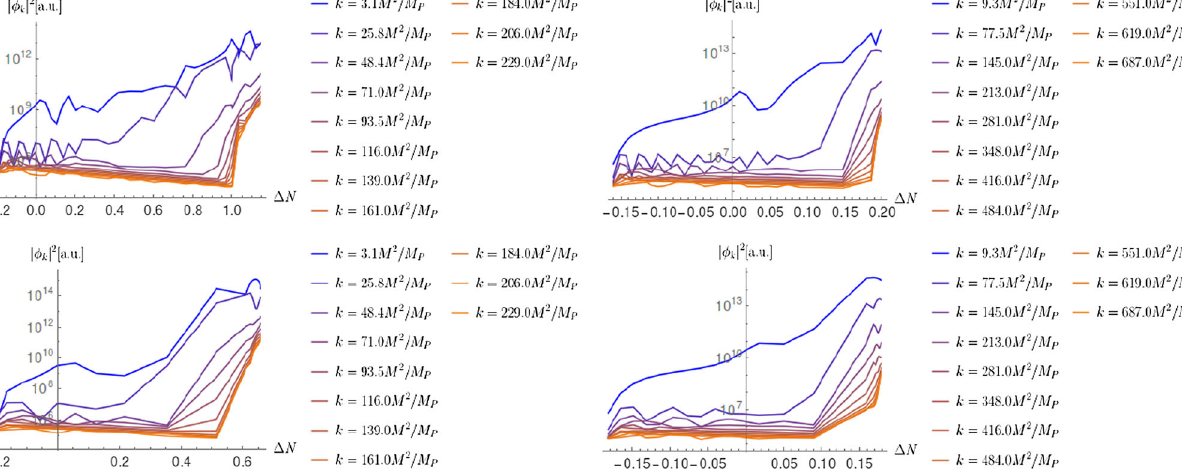
Fig. 9 The time evolution of the inflaton perturbations for n = 1 ,α = 10 − 3 (upper left), n = 1 ,α = 10 − 4 (upper right), n = 1 . 5 ,α = 10 − 3 (lower left), n = 1 . 5 ,α = 10 − 4 (lower right) for different number of wavenumbers